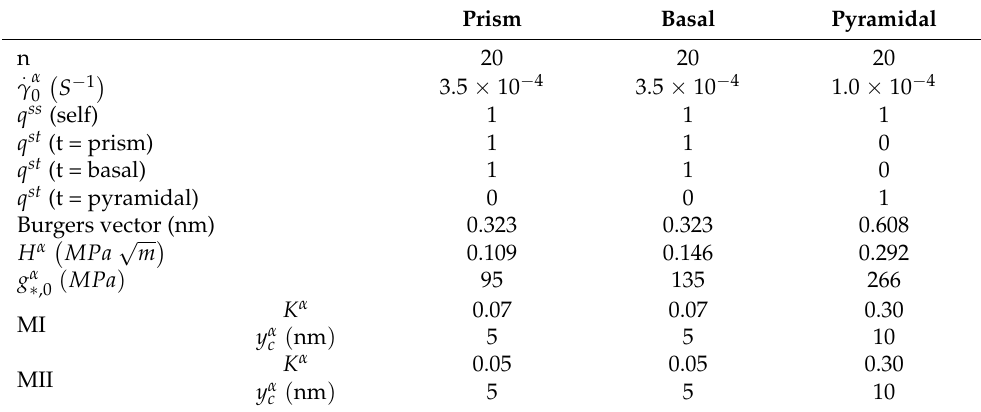
Table 1. Single crystal parameters used in the hardening law for HCP zirconium from Sedaghat and Abdolvand